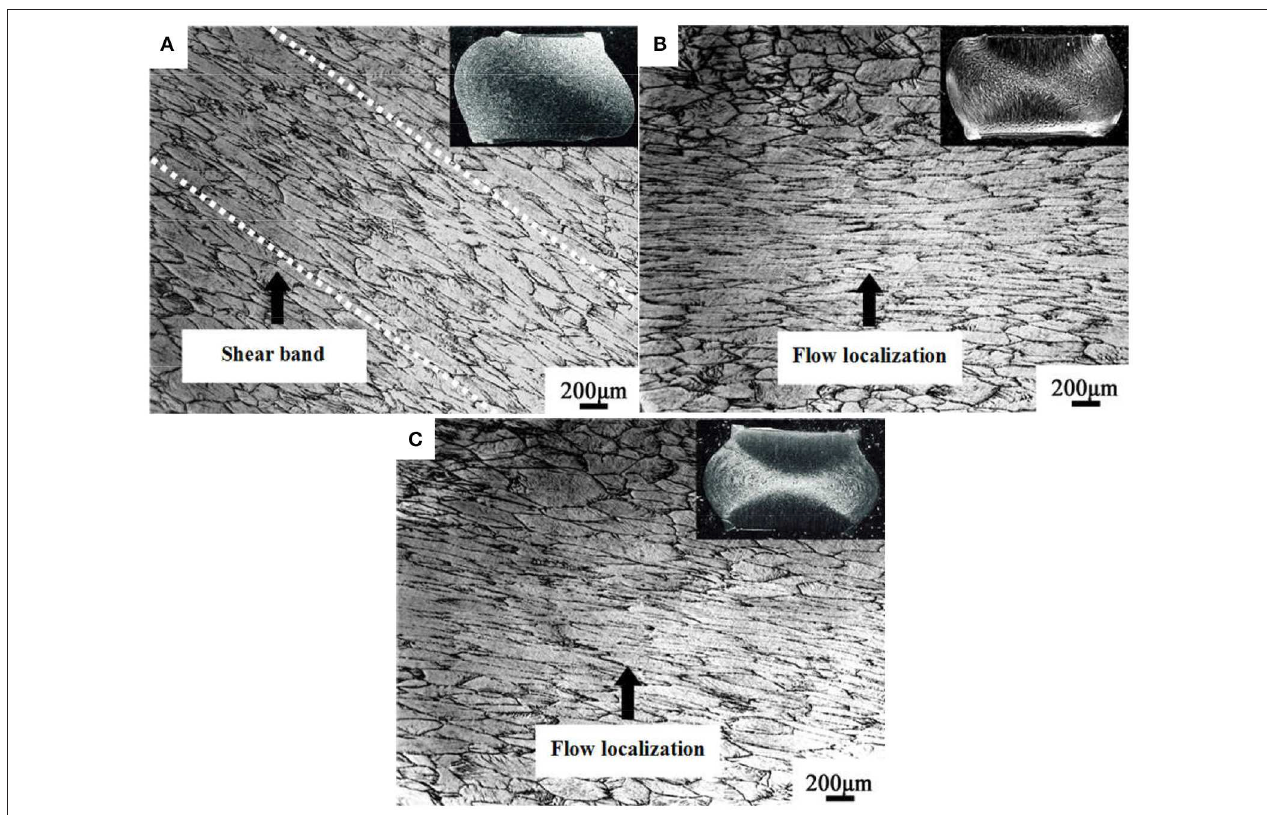
FIGURE 9 | The microstructures obtained in the instability region of the Ti-25.5Al-13.5Nb-2.8Mo-1.8Fe alloy: (A) Shear band at 950 ◦ C/1 s − 1 ; (B) flow localization at 950 ◦ C/10 s − 1 ; and (C) flow localization at 1,000 ◦ C/10 s − 1 .